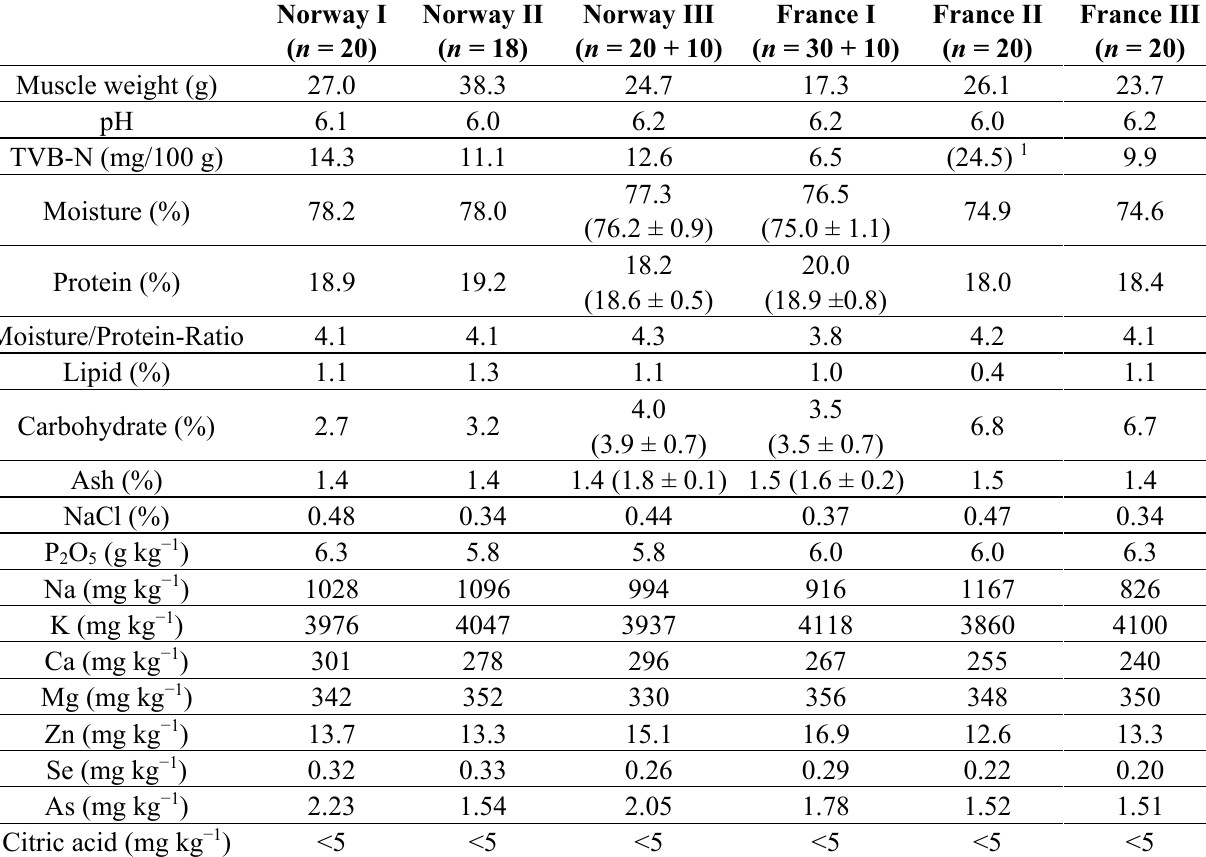
Table 1. Proximate composition of fresh king scallops (wet weight) from different harvest areas, Norway (I-III) and France (I-III): mean values for pooled samples of n individuals and mean values ± standard deviation for n = 10 individually analyzed specimens (results in